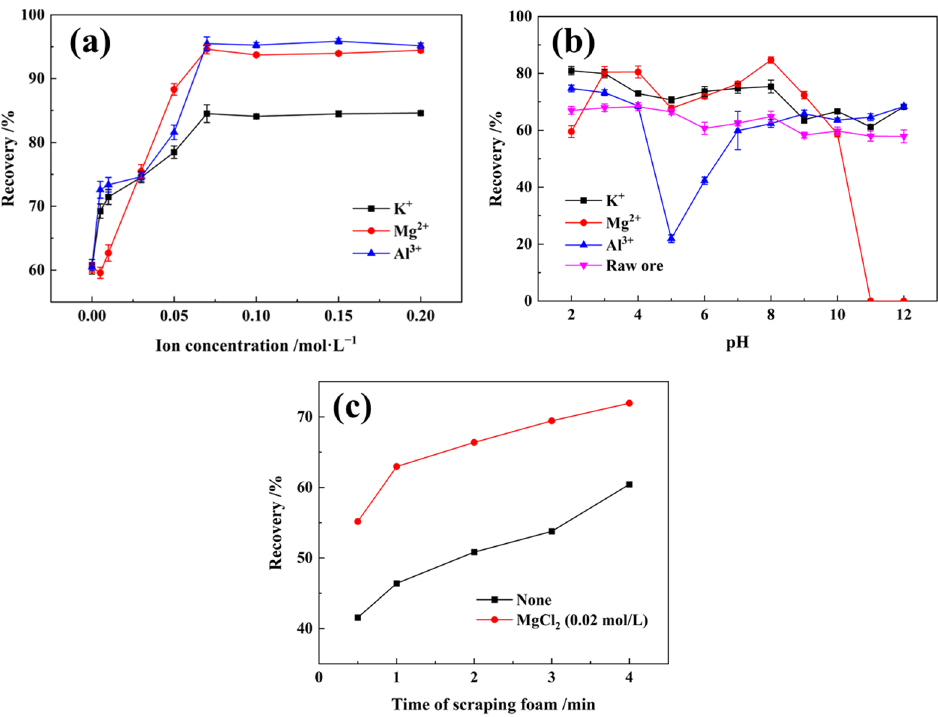
Figure 3. ( a ) The effect of inorganic salt concentration on graphite flotation; ( b ) The effect of pH on the flotation of graphite in the presence of inorganic salt ions; ( c ) Comparison of the flotation performance of graphite under different scraping times with and without MgCl 2